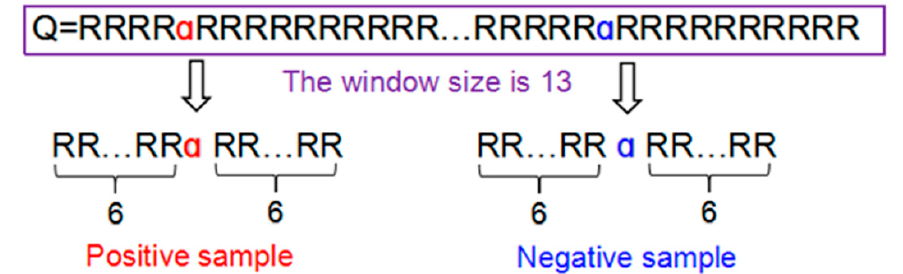
Figure 8. The process of formulating the positive and negative peptide samples.